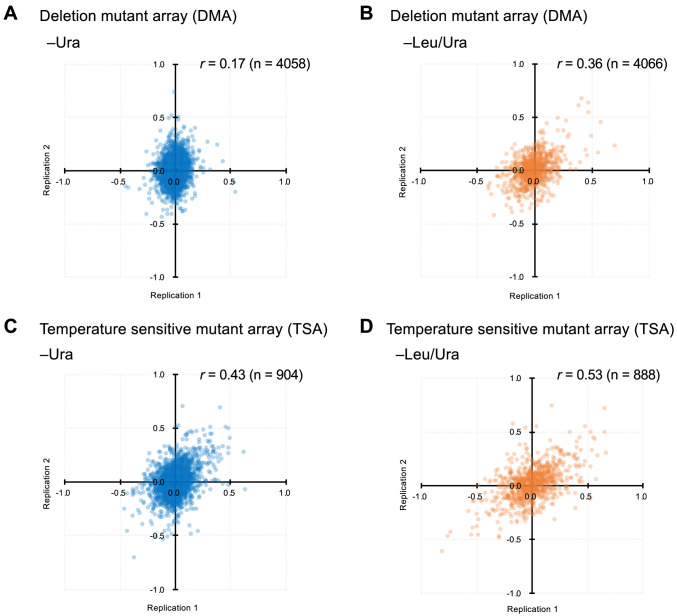
Comparison of GI scores from experimental duplicates.(A-D) indicates the conditions and mutants used.